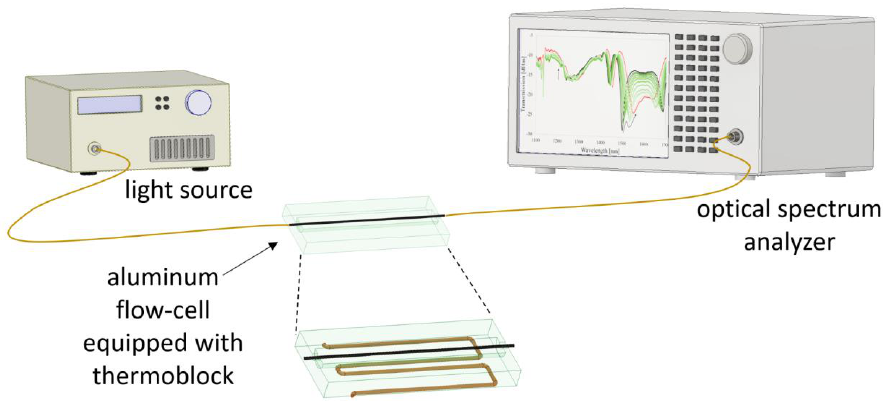
Figure 2. Schematic representation of the measurement setup.